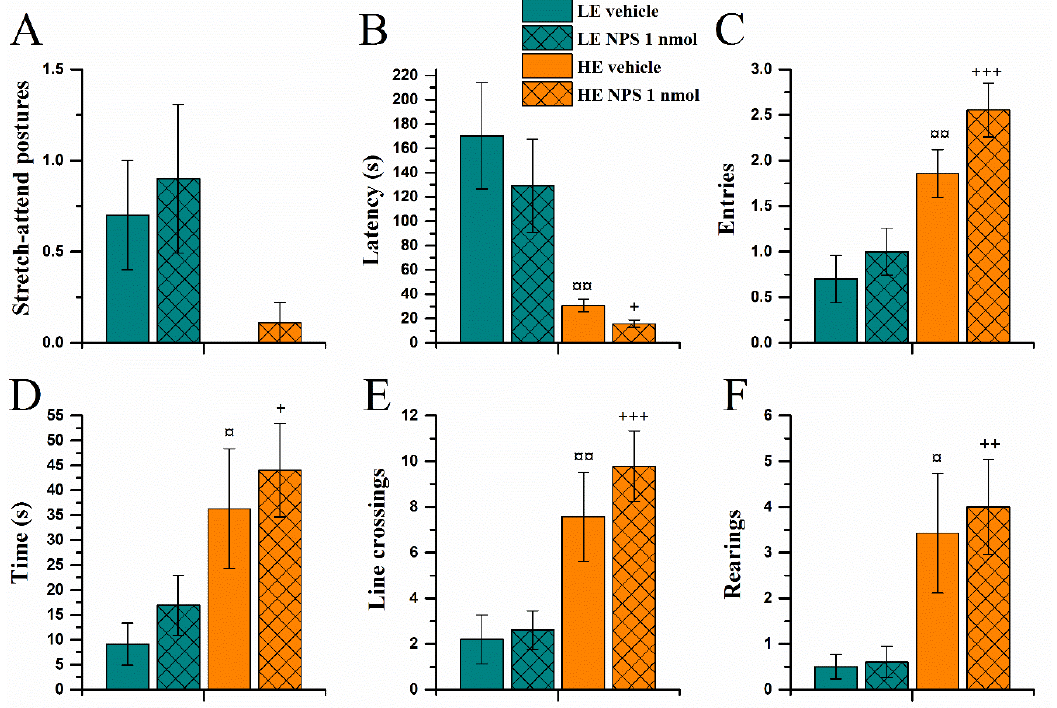
Figure 8. Behaviour in the light-dark box approximately 55 min after vehicle/NPS (1 nmol, i.c.v.) administration: strech- attend postures ( A ), latency to enter ( B ), entries into ( C ), time spent, ( D ), line crossings ( E ), and rearings in the light part of the apparatus (data shown as mean ± SEM). ( F ) ¤, ¤¤: p < 0.05, 0.01 vs. LE vehicle, respectively; +, ++, +++: p < 0.05, 0.01, 0.001 vs. LE NPS, respectively. HE: high exploring rats; LE: low exploring rats; NPS: neuropeptide S. HE vehicle ( n = 7); HE NPS ( n = 9); LE vehicle ( n = 10); LE NPS ( n = 10).